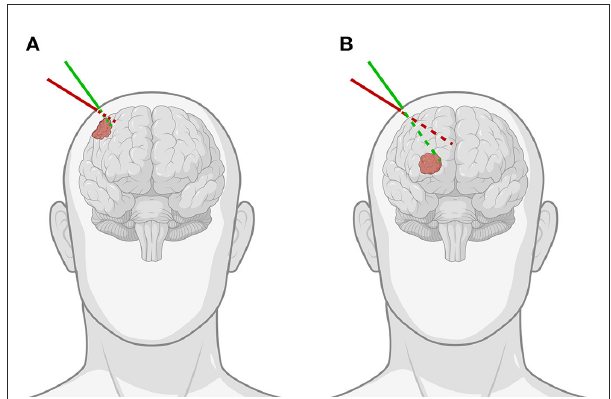
FIGURE1 Demonstration of the importance of the angle of approach when using pointer-based neuronavigation for (A) superficial as opposed to (B) deep-seated tumors. The green line indicates the correct angulation of the stylus for the chosen entry point, while the red line shows how for the same entry point, improper angulation can lead to important differences in trajectory and offset to the tumor, especially for deep-seated tumors [Created with BioRender.com].